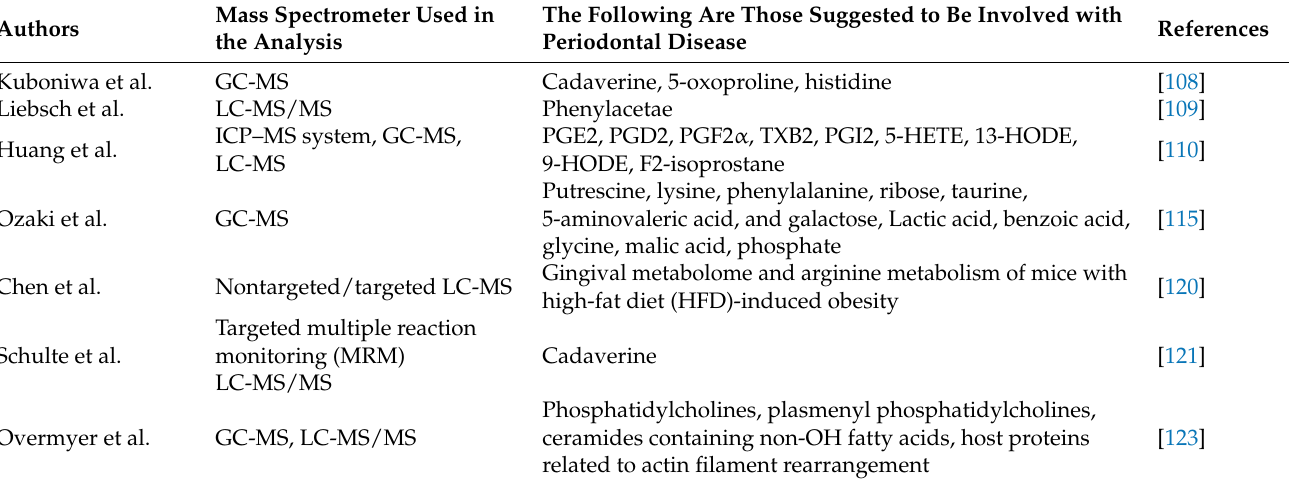
Table 2. Summary of important findings of these